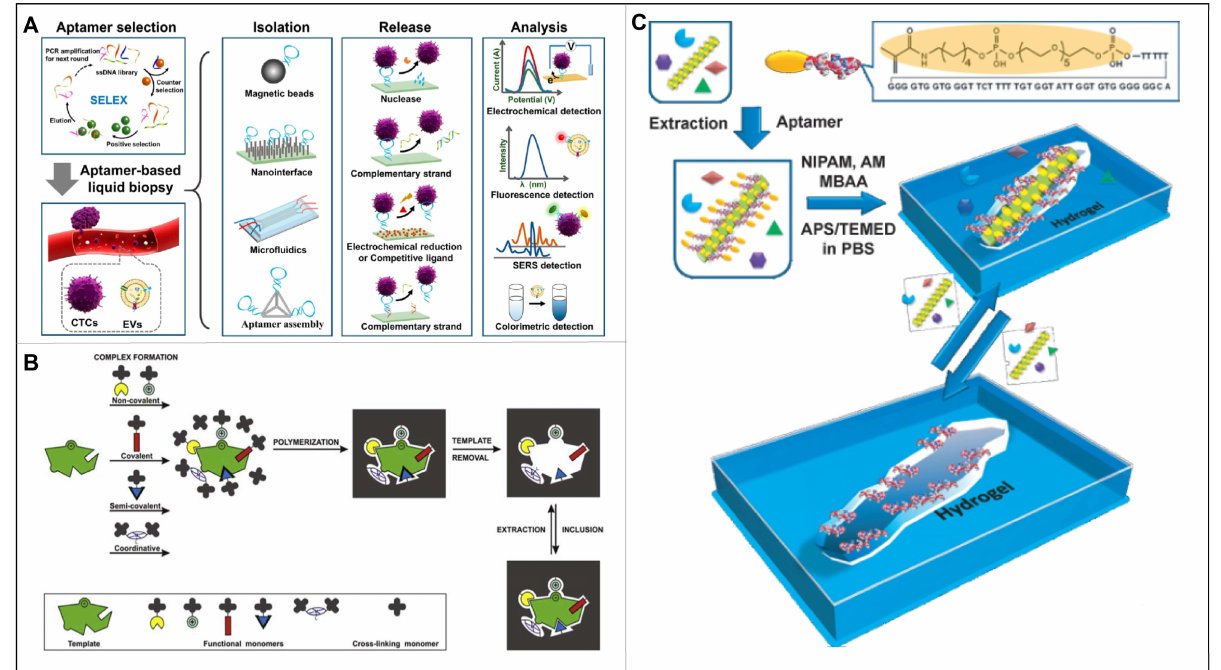
Figure 2. ( A ) Schematic diagram for aptamer selection and aptamer-based liquid biopsy. Reproduced with permission from [18]. ( B ) Consecutive steps of preparing, in different ways, a molecularly im- printed polymer. Reproduced with permission from [19]. ( C ) Schematic illustration of the bioimprint- ing process used to create virus responsive super-aptamer hydrogels. Reproduced with